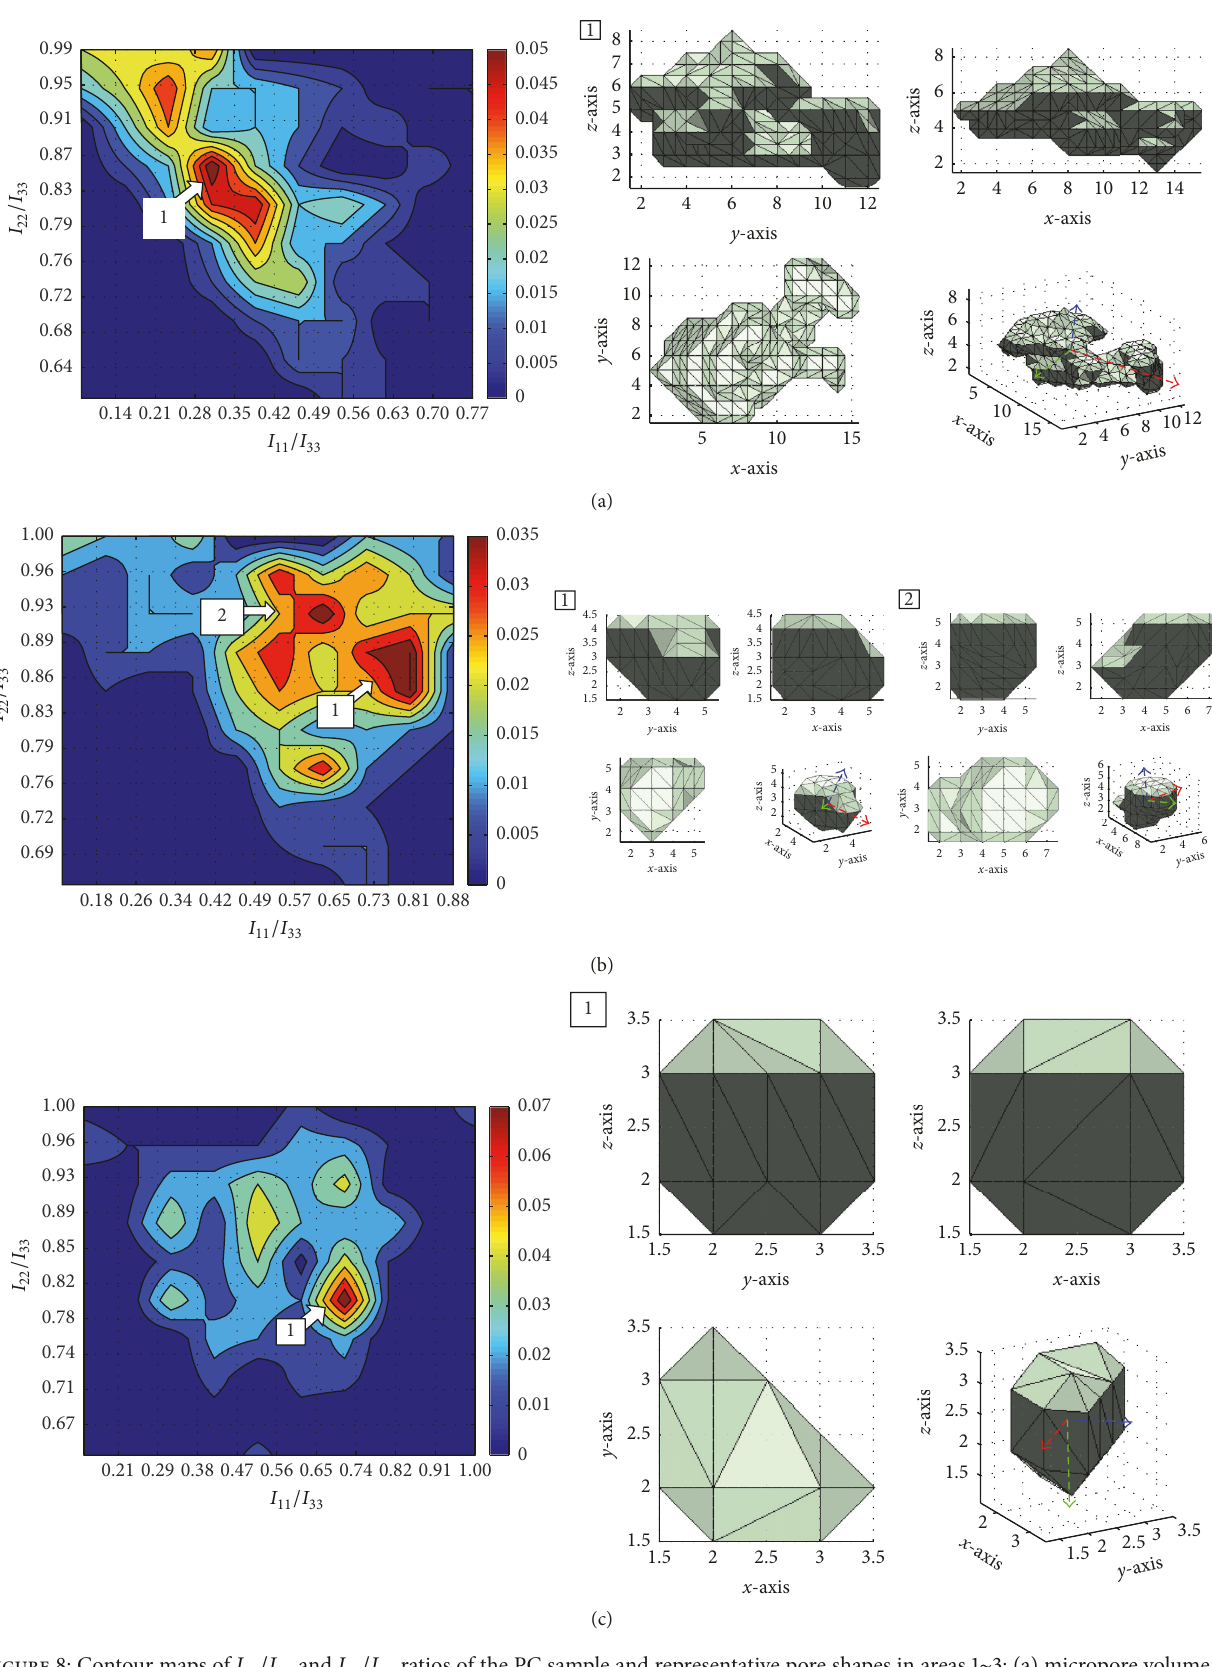
Figure 8: Contour maps of 𝐼 11 /𝐼 33 and 𝐼 22 /𝐼 33 ratios of the PC sample and representative pore shapes in areas 1 ∼ 3: (a) micropore volume ≥ 10 −3 mm 3 , (b) micropore volume 10 −3 ∼10 −4 mm 3 , and (c) micropore volume < 10 −4 mm 3